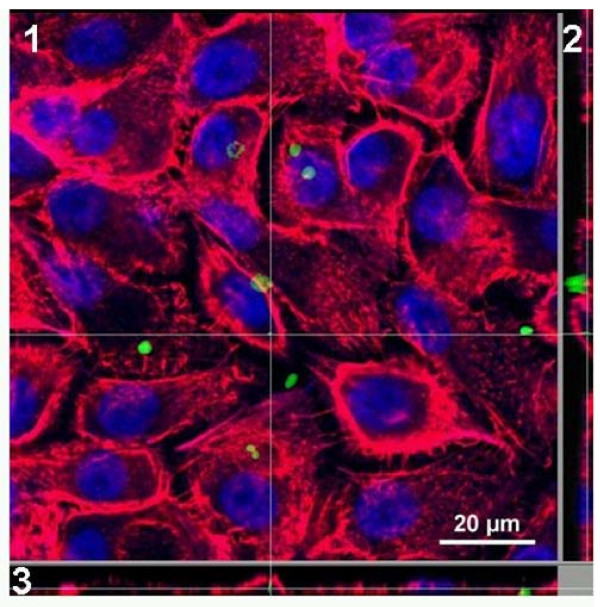
Confocal microscopy of SPP uptake into normal human bronchial epithelial cells. Cells were incubated for 8 hours with 5 × 106/cm2 Alexa Fluor 488 labelled subpollen particles (green) in chamber slides. Cell cytoskeletons were stained with an antibody against F-Actin (Rhodamine phalloidin, red) and nuclei staining was performed by TO-PRO-3 Iodide (blue). Three dimensions along the white lines are shown. The intersection displays an internalized SPP.